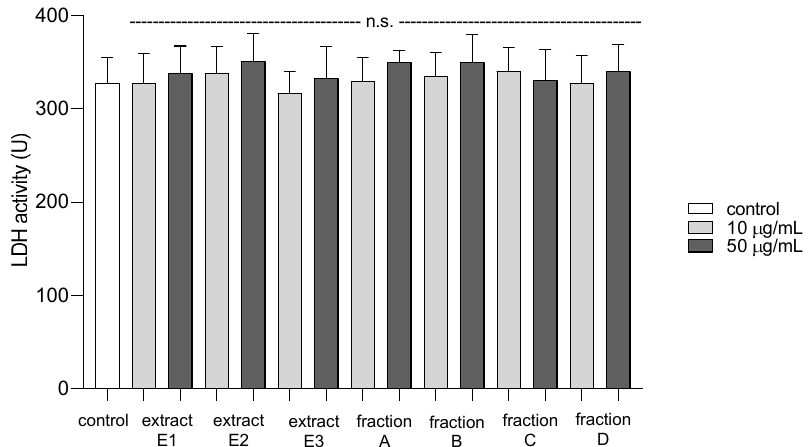
Figure 13. Cytotoxic effect of extracts (E1–E3) and flavonoid fractions (A–D) of dandelion fruits (concentrations: 10 and 50 µg/mL) on human blood platelets. Data are presented as means ± SD ( n = 4); n.s. p > 0.05, compared with control.